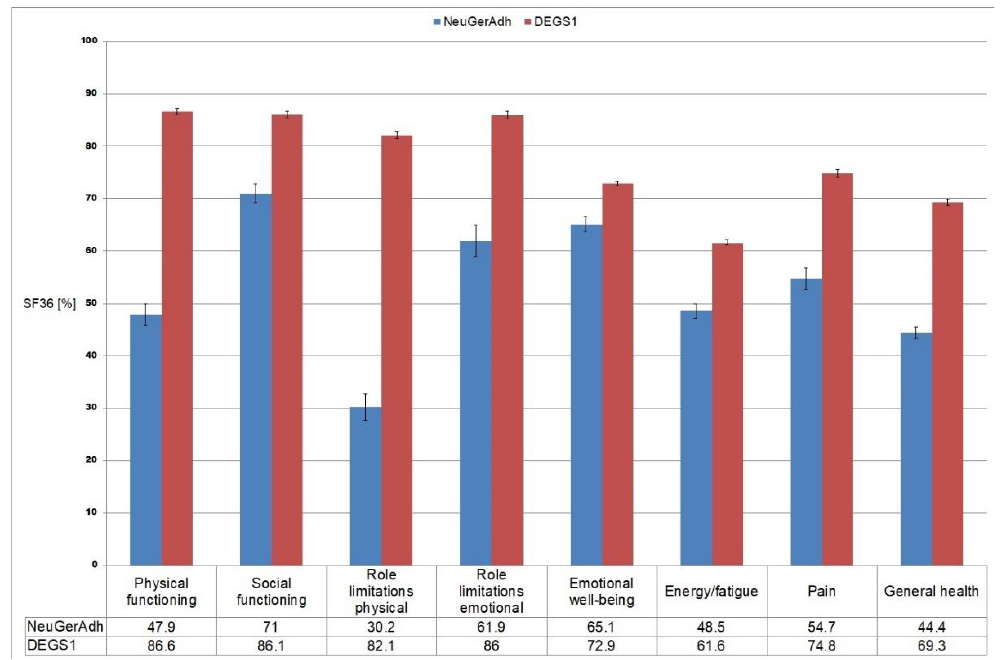
Figure 1. Mean and 95% Confidence intervals from SF-36 domains in comparison with the general German population. Note : NeuGerAdh = Data from the current study, DEGS1 = German Health Interview and Examination Survey for Adults Table 1. Clinical and demographical characteristics.